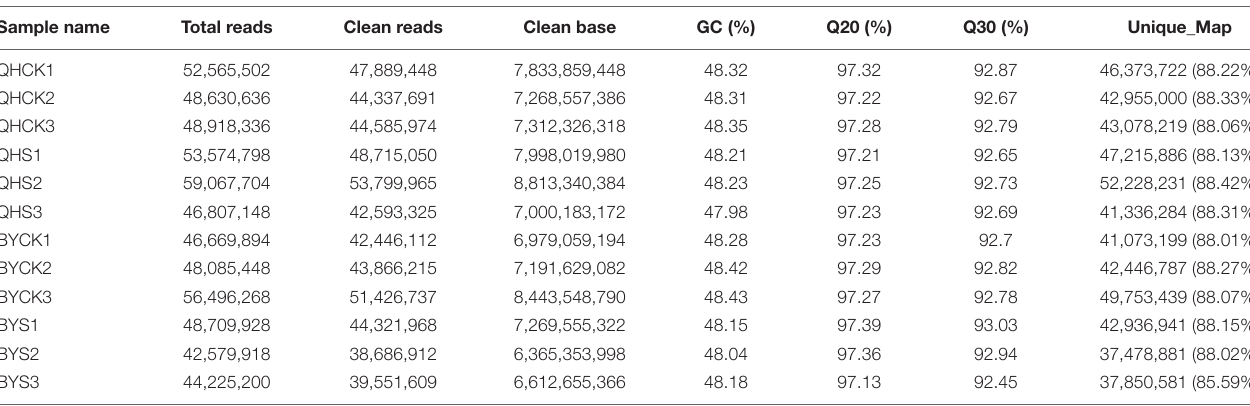
TABLE 2 | Sequencing data for 12 libraries obtained by RNA